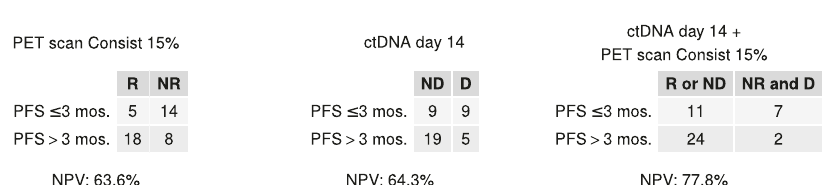
Fig. 1 Kaplan – Meier plots of PFS according to 18 F-FDG-PET/CT response and ctDNA detection 14 days after the start of treatment with exemestane-everolimus. a PFS plots according to 18 F-FDG-PET/CT response on D14: patients with >25% homogenous decrease in maximum standardized uptake value (SUVmax) in all target lesions are considered as “ responders ” . b PFS plots according to 18 F-FDG-PET/CT response on D14: patients with a > 15 % homogenous decrease in maximum standardized uptake value (SUVmax) in all target lesions are considered as “ responders ” . This is a “ post-hoc ” analysis, initially not scheduled by the study protocol. c PFS according to ctDNA detection at baseline (40-gene targeted gene sequencing panel was realized in all plasma samples). d PFS according to ctDNA detection after 14 days of treatment with exemestane-everolimus. e PFS according to the combined analysis of ctDNA detection and 18 F-FDG-PET/CT response when patients with >25% homogenous decrease in maximum standardized uptake value (SUVmax) in all target lesions are considered as “ responders ” . f Combined analysis of ctDNA detection and 18 F-FDG-PET/CT response when patients with >15% homogenous decrease in maximum standardized uptake value (SUVmax) in all target lesions are considered as “ responders ” . The 15% cut-off is a “ post-hoc ” analysis, initially not scheduled by the study protocol. Log-Rank P values and LogRank Hazard ratios and 95% Con fi dence intervals for LogRank Hazard ratios for each test are displayed in each corresponding panel. For each group, the number at risk is presented under the X -axis. Consist criteria of